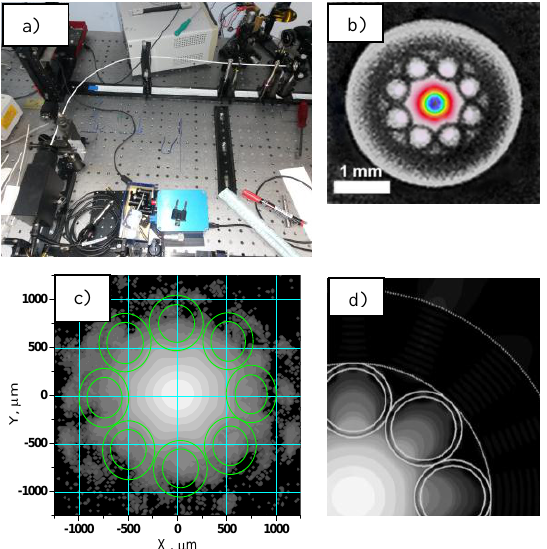
Fig.3 a) Experimental scheme photo, (b) and (c) THz field distribution of TLF mode cross-section in linear (b) and log (c) scales measured by THz camera. (d) Theory for fundamental mode field distribution in log scale.